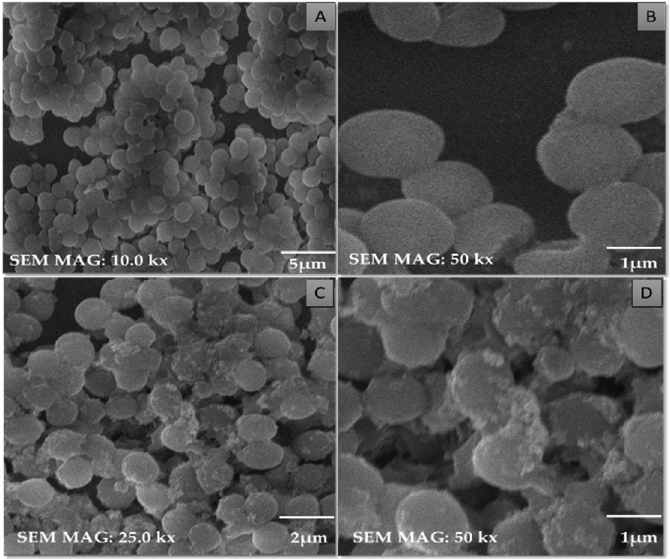
Figure 12. Untreated S. aureus at ( A ) 5 μ m, ( B ) 1 μ m. Action of CI-TiO 2 -MSs on S. aureus detected by SEM at ( C ) 2 μ m, ( D ) 1 μ m.